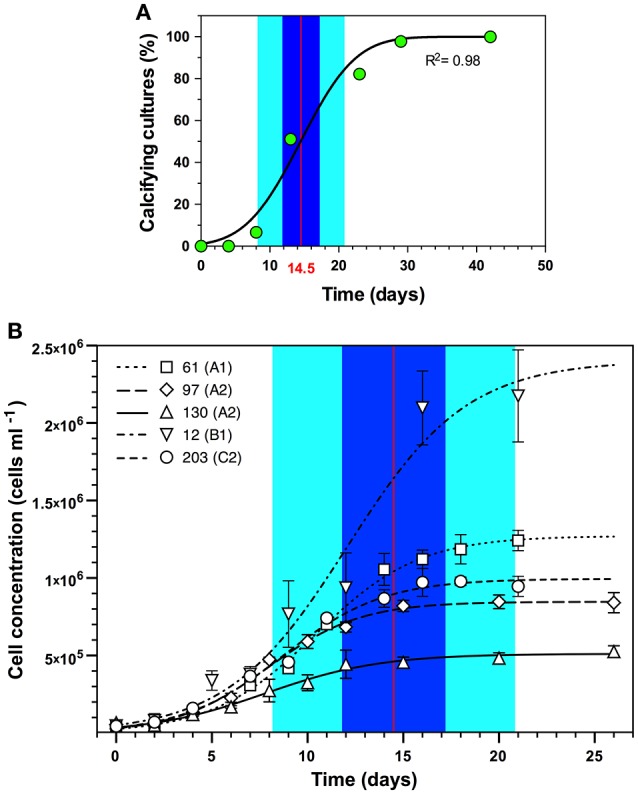
Onset of symbiolite formation in relation to Symbiodinium spp. growth dynamics. (A)
Symbiodinium spp. cultures, inoculated 1:40 (~25,000–50,000 cells mL−1) in f/2 medium on average started to calcify after 14.5 days (red vertical line) with a 95% confidence interval from 11.8 to 17.2 days (Blue area) and a standard deviation of 6.3 days (light cyan area) (n = 45). (B) Projection of calcification dynamics in (A) onto growth curves of five of the 45 Symbiodinium strains (61, 97, 130, 12, and 203; ITS2-type designations in brackets) inoculated with 25,000–50,000 cells mL−1. Data are means ± s.d. (n = 3). Logistic functions were fitted to growth curves using the software Plot (version 1.997, http://plot1.micw.org).